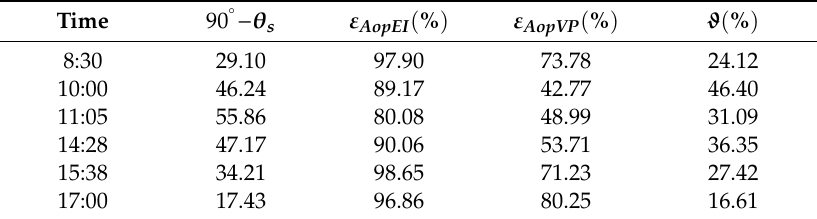
Table 2. Similarity and degree of improvement after experimental improvement.